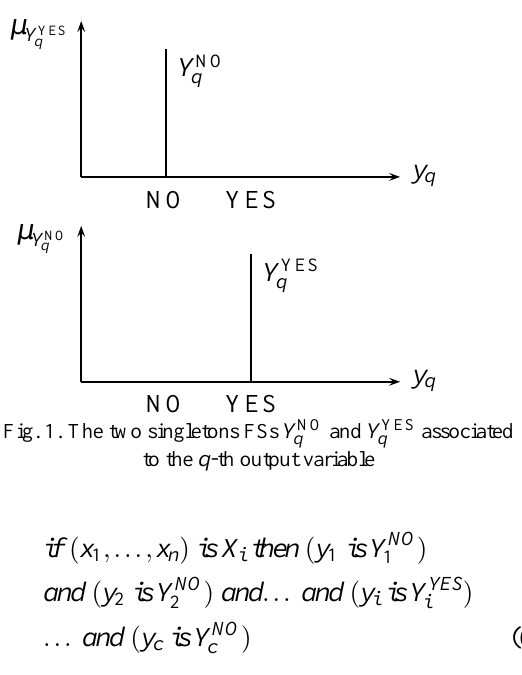
Fig. 1. The two singletons FSs Y NO q and Y YES q associated to the q -th output variable